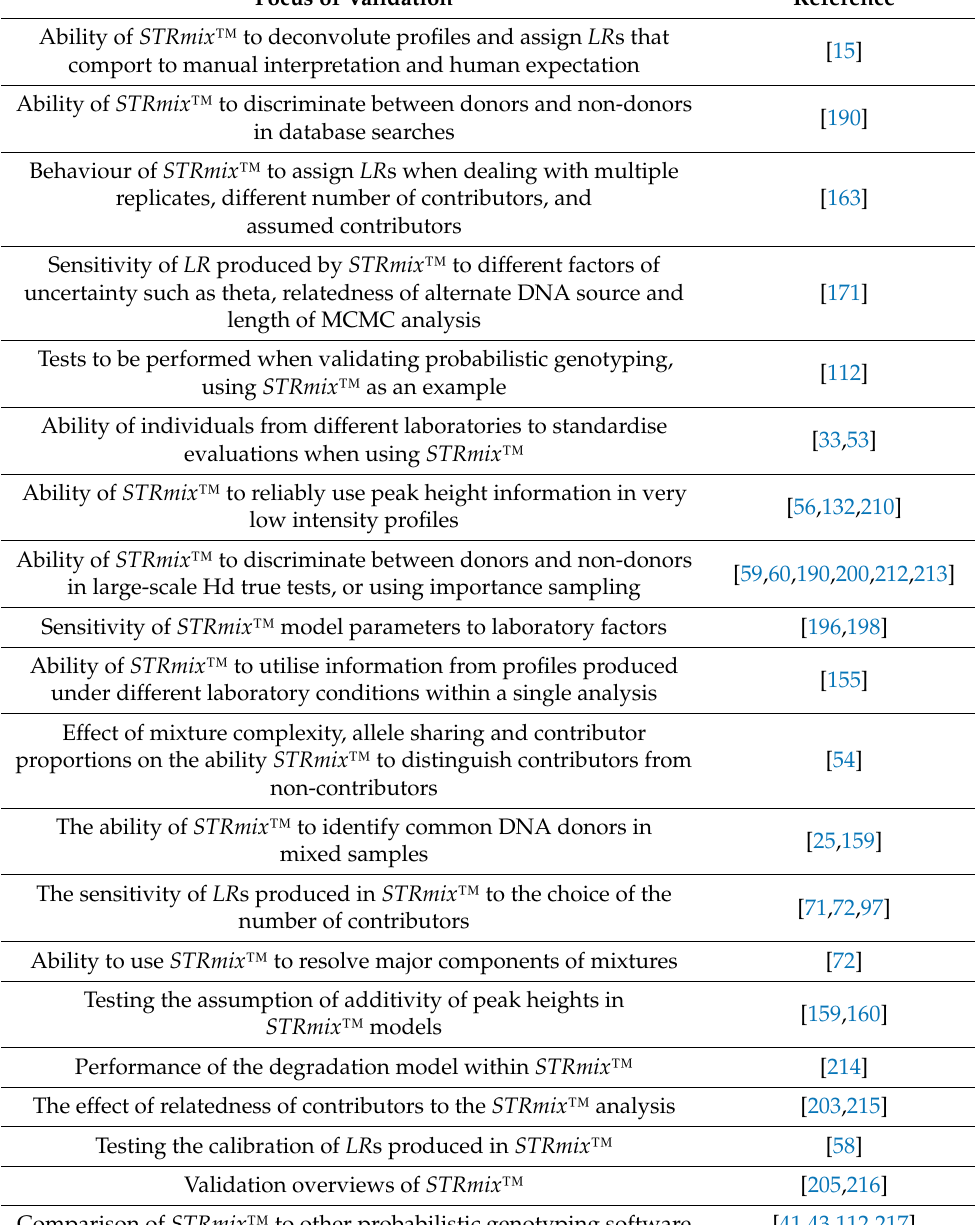
Table 2. Publications of validation of STRmix ™